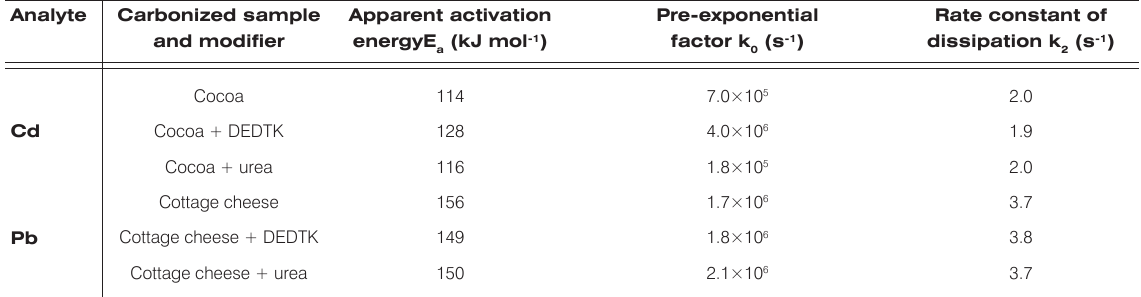
Table 1. Kinetic parameters of Pb and Cd atomization from solid carbonized food (atomization temperatures were 1873 and 1673 K respectively).